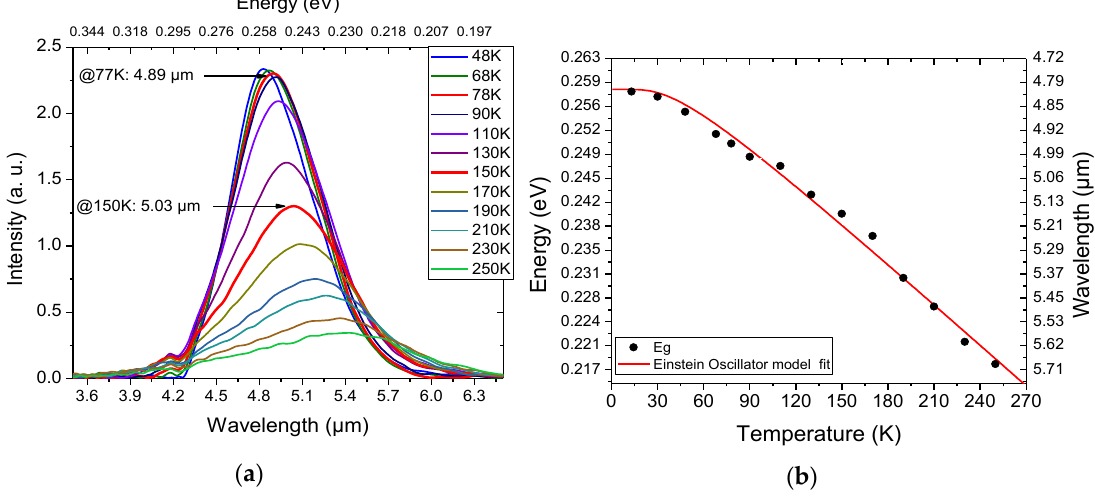
Figure 6. ( a ) Photoluminescence (PL) spectra of the Ga-free InAs / InAs 0.63 Sb 0.37 T2SL structure between 48 and 250 K. ( b ) Ga-free T2SL bandgap variation as a function of the temperature. The red line presents a fit curve using Einstein oscillator equation.